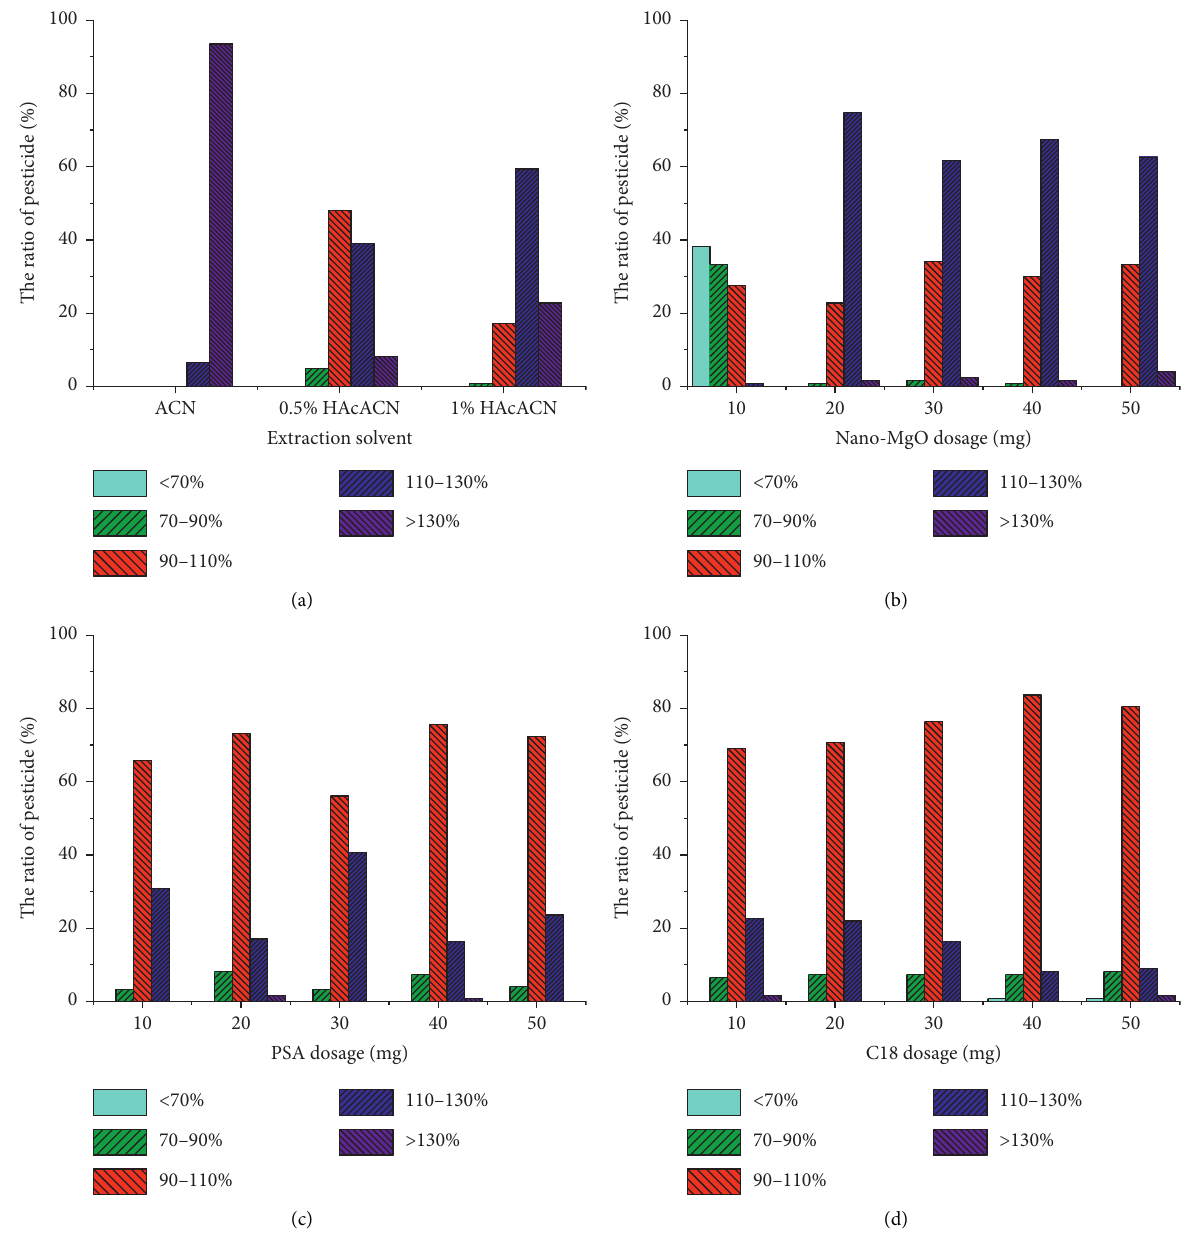
Figure 2: Influence of the extraction solvent (a), nano-MgO dosage (b), PSA dosage (c), and C18 dosage (d) on the pesticide recovery